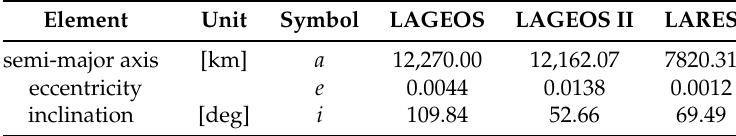
Table 1. Mean orbital elements of the satellites.